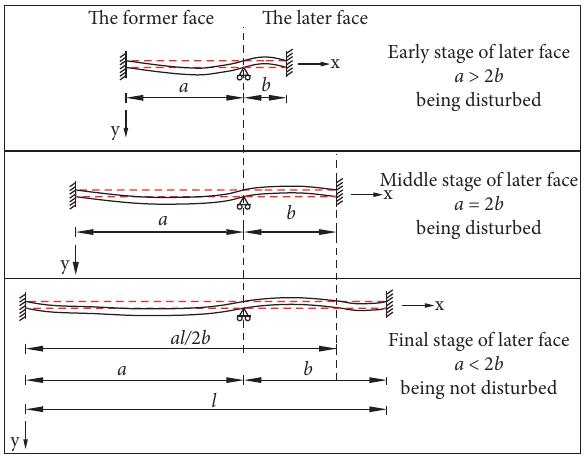
Figure 6: The change of conglomerate’s form in the process of two mining